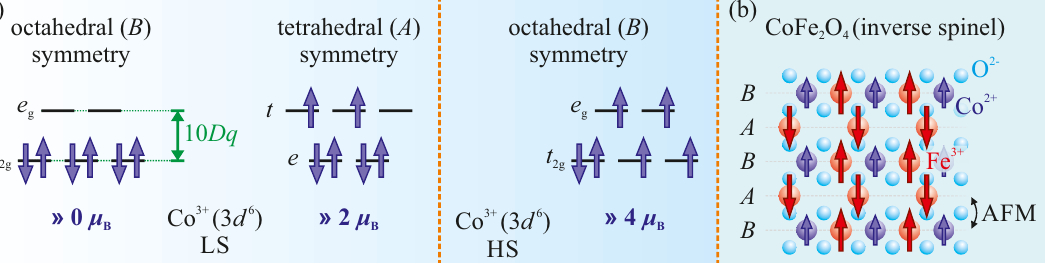
Figure 5. ( a ) The occupation of the 3 d states of Co 3 + in the low-spin (LS) state at either octahedral B or tetrahedral A lattice sites, including the resulting net spin moments. The occupation of octahedrally coordinated Co 3 + in the high-spin (HS) state is shown for comparison. ( b ) Antiferromagnetic (AFM) coupling between cations at octahedral B and tetrahedral A lattice sites for stoichiometric CoFe 2 O 4 as an inverse